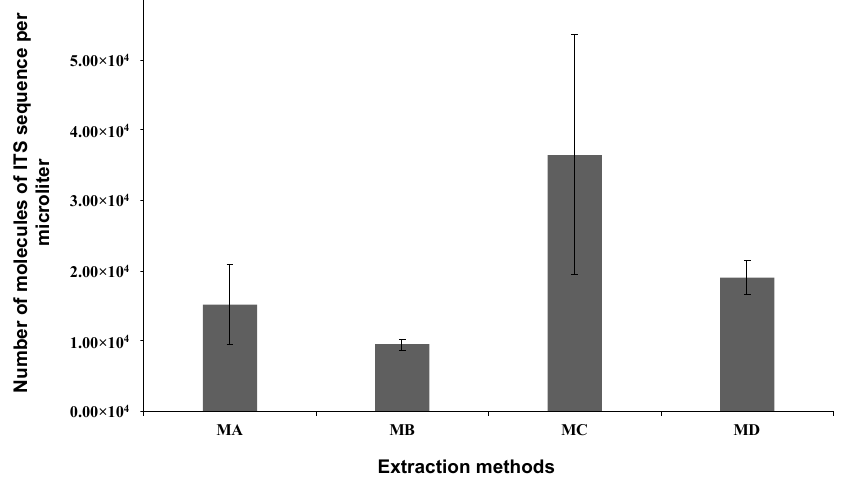
Figure 5. Absolute quantification of C. gloeosporioides DNA purified using four in-house developed simplified DNA extraction methods (MA, MB, MC, and MD; details in Table S1). Paper strips were used to purify the DNA from the samples and elute it into 25 µL Milli-Q. Purification was performed in triplicate ( n = 3), and qPCR quantification values were used to calculate the initial concentration of ITS sequence in each amplification reaction. All bar graphs represent the mean of three replicates, and error bars represent the